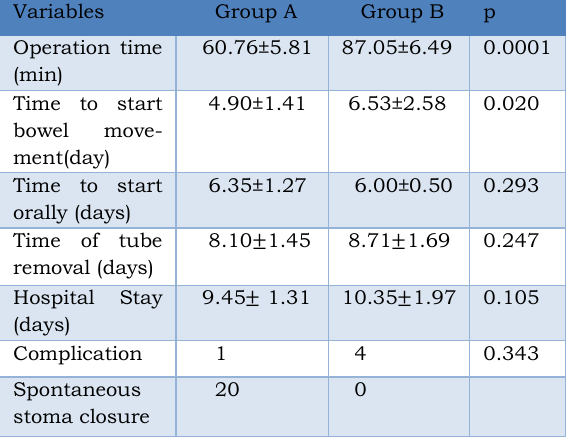
Table 2: Distribution of dependent variables between two